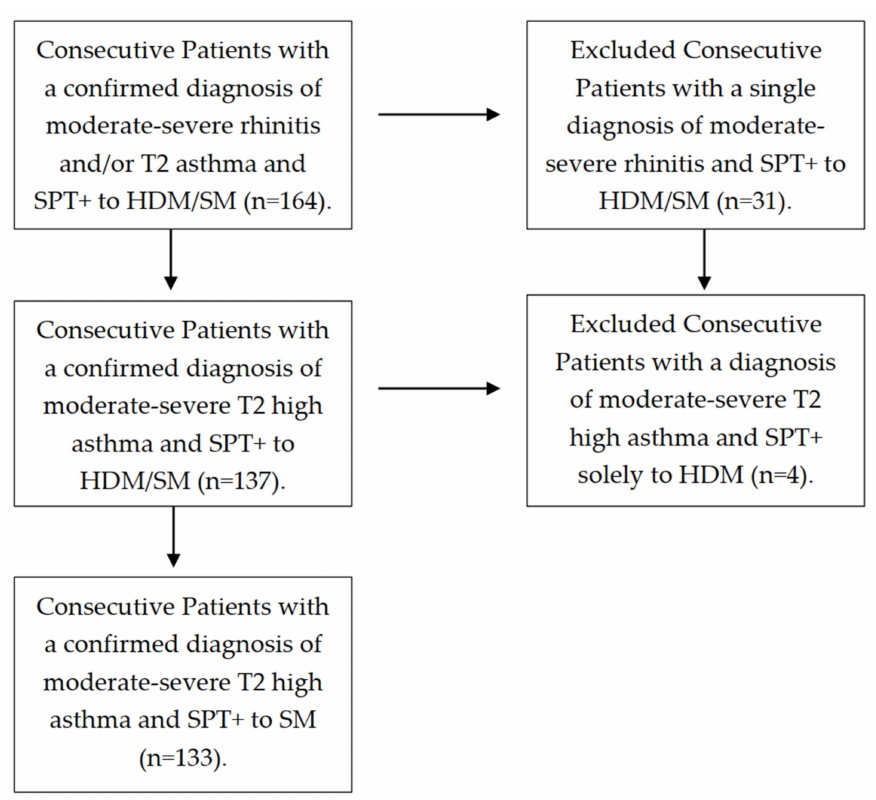
Figure 1. Flow diagram of study